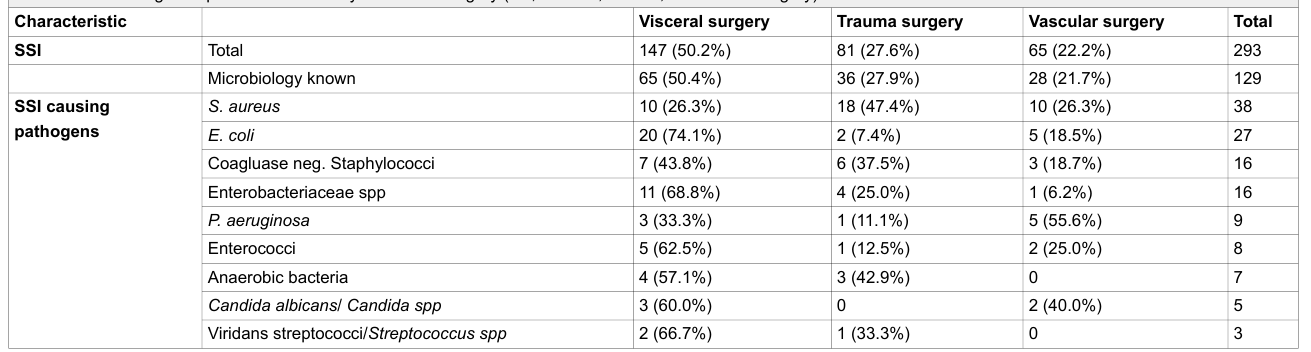
Table 1: Identified germ spectrum stratified by division of surgery (i.e., visceral, trauma, or vascular surgery). Characteristic Visceral surgery Trauma surgery Vascular surgery